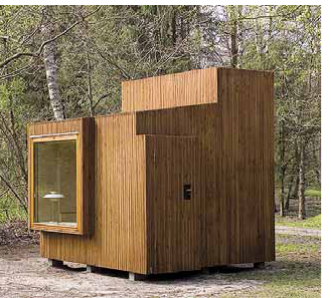
Fig. 6. Weekend house – villa “Mecklin” in the Fig. 5. Movable house – cabin,